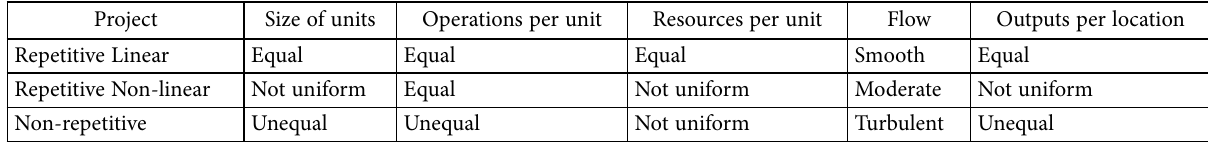
Table 1. Classification, proposed by Murguia and Urbina (2018) Project Size of units Operations per